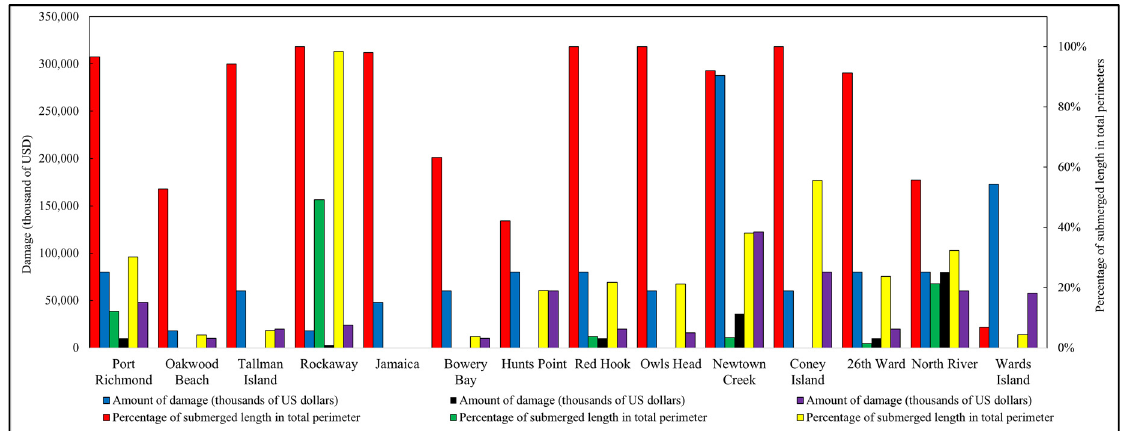
Figure 5. Percentage of the submerged length of buildings to the total perimeter of buildings and amount of damage caused by storm surge, high-intensity rainfall, and sea level rise.